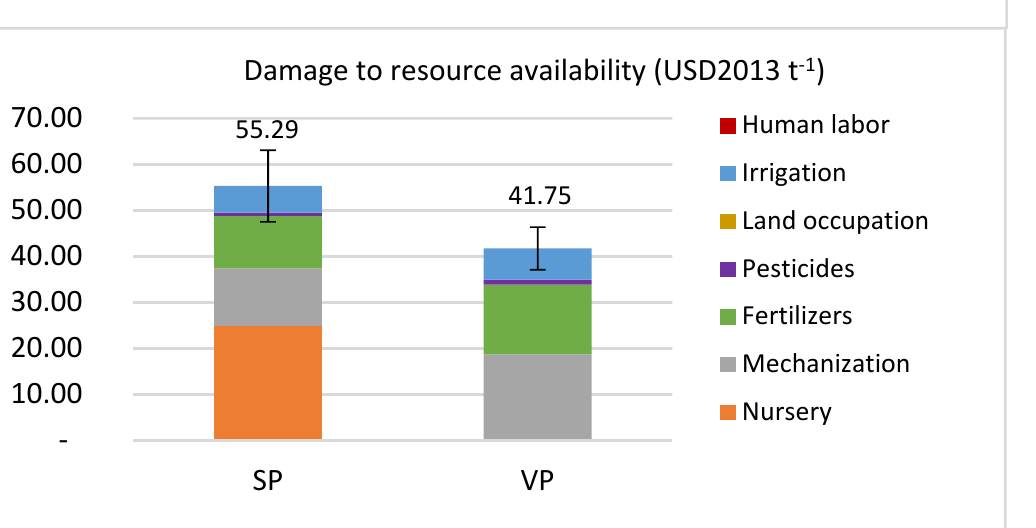
Figure 4. Cradle-to-farm gate ReCiPe 2016 endpoint impacts for 1 ton of seed propagated (SP) and vegetative propagated (VP) globe artichoke.